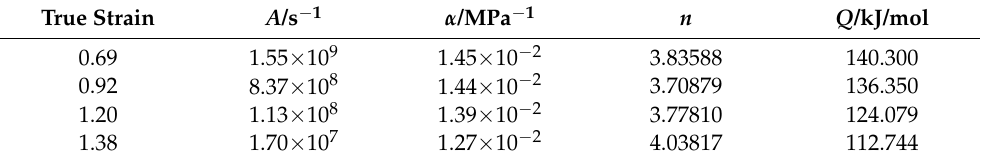
Table 2. Values of α , n, Q and A of Arrhenius constitutive model in different amounts of deforma- tion strain.